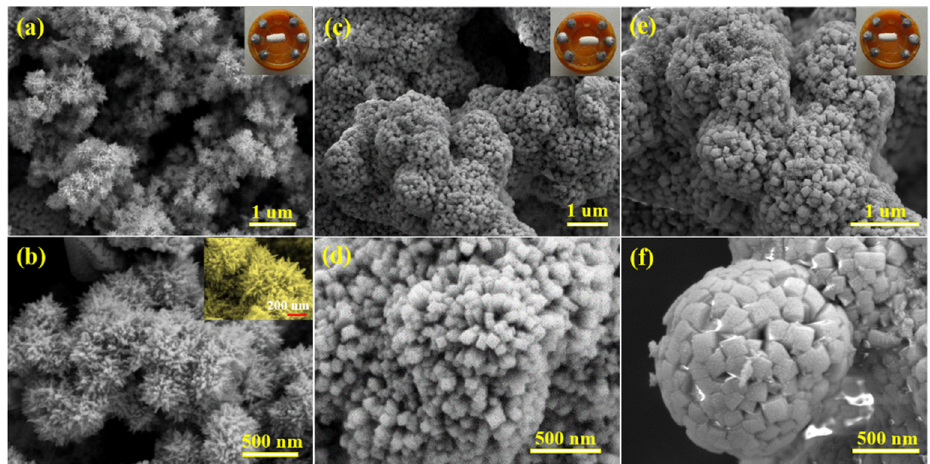
Figure 2. FE-SEM images of three SnO 2 samples: ( a , b ) SN-1, ( c , d ) SN-2, ( e , f ) SN-3 (the inserts of ( a , c , e ) are the corresponding optical images of gas sensors; the insert of ( b ) is its magnified image). Table 1. Comparison of different SnO 2 structures in this study and other literature.